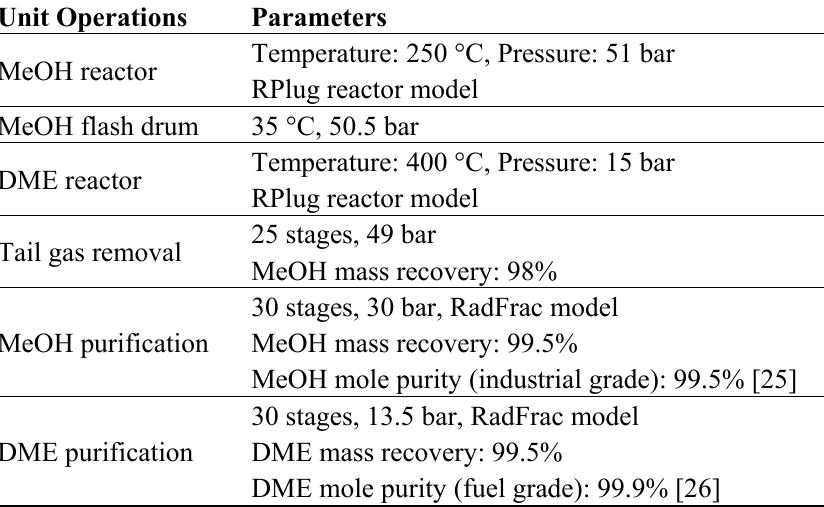
Table 3. Main design parameters of the Methanol/DME synthesis